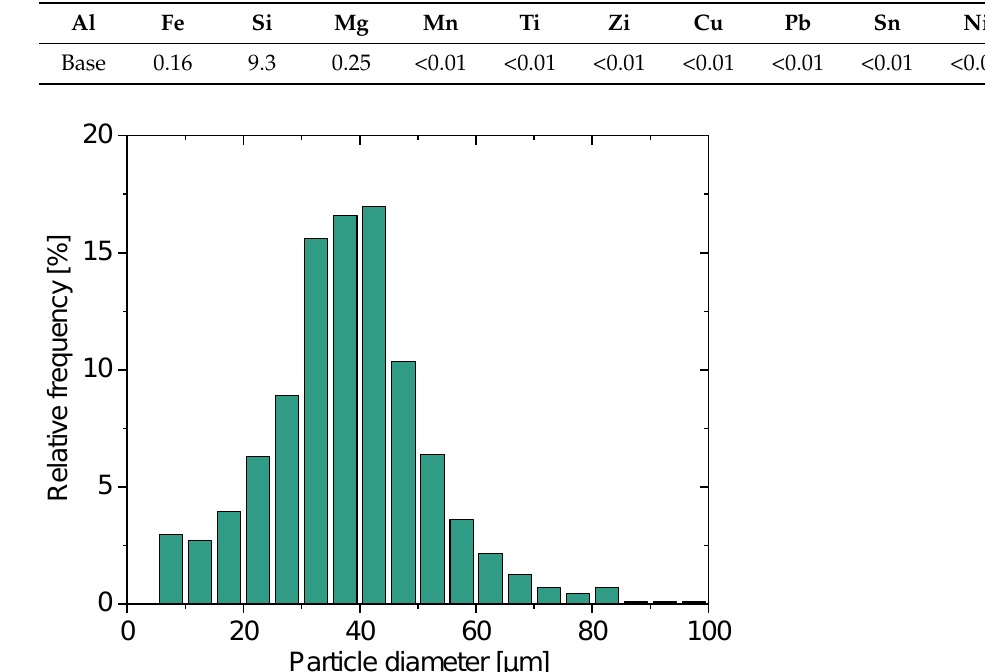
Figure 2. Particle size distribution of the powder used in this